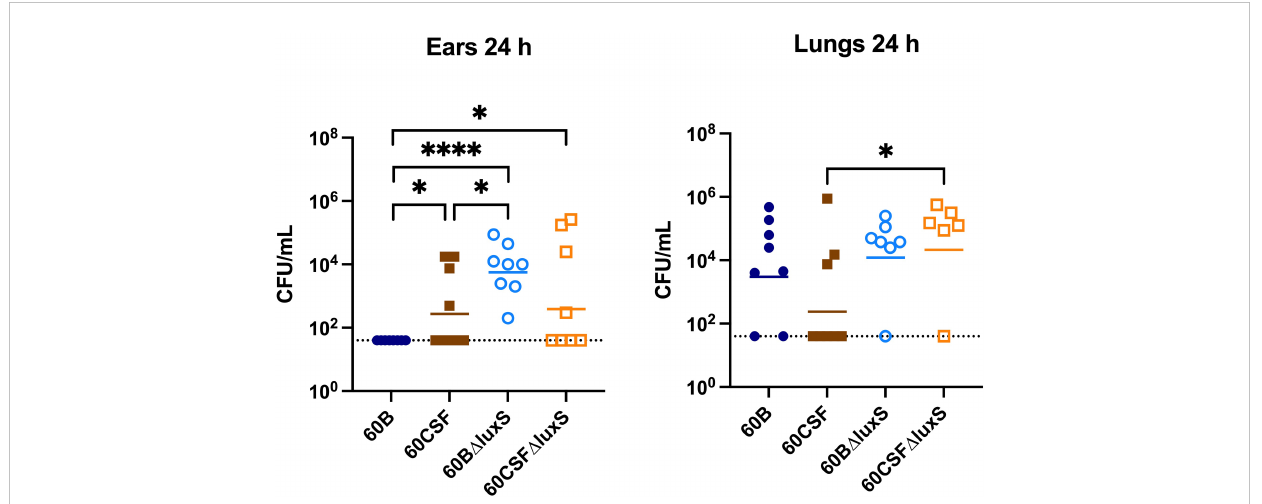
FIGURE 8 Virulence phenotypes of 60B, 60CSF, 60B D luxS and 60CSF D luxS strains. Groups of 8 mice were infected intranasally with 10 8 CFU of the indicated strain. At 24 h, mice from each group were humanely euthanized and pneumococci in the brain, ear, lungs and nasal tissue were enumerated. Viable bacterial counts are displayed for each mouse in the ears and lungs (brain and nose data in Supplementary Figure 5); horizontal bars indicate the geometric mean (GM) CFU for each group; the dotted line indicates the detection threshold. Signi fi cance of differences in bacterial load between groups was determined using two-tailed Student ’ s t test; *P < 0.05, ****P <